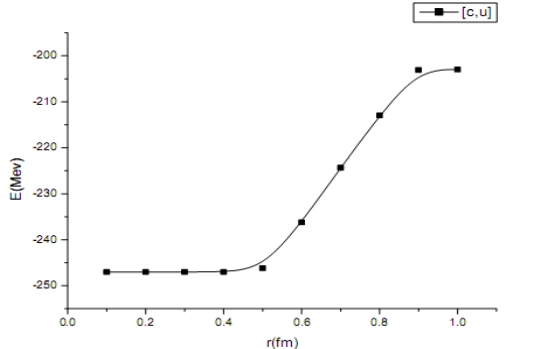
Figure 3: Variation of Binding Energy with R_cutoff Variation. At the distance below 0.1 fm, diquark-antidiquark form a tetraquark since the figure shows minimum r at this point, where the binding energy is -247 Mev. This energy remains constant at